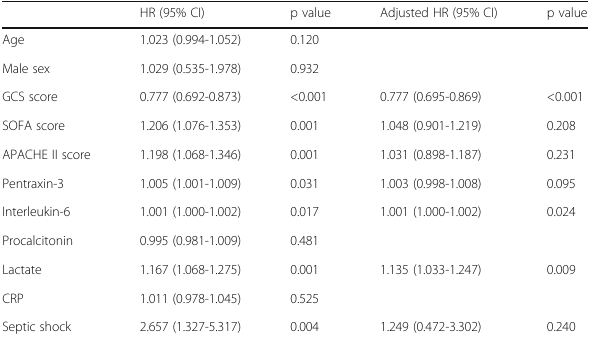
Table 3 (abstract P14). Univariate and Multivariate Cox Proportional Model of Risk Factors for 28-day Mortality